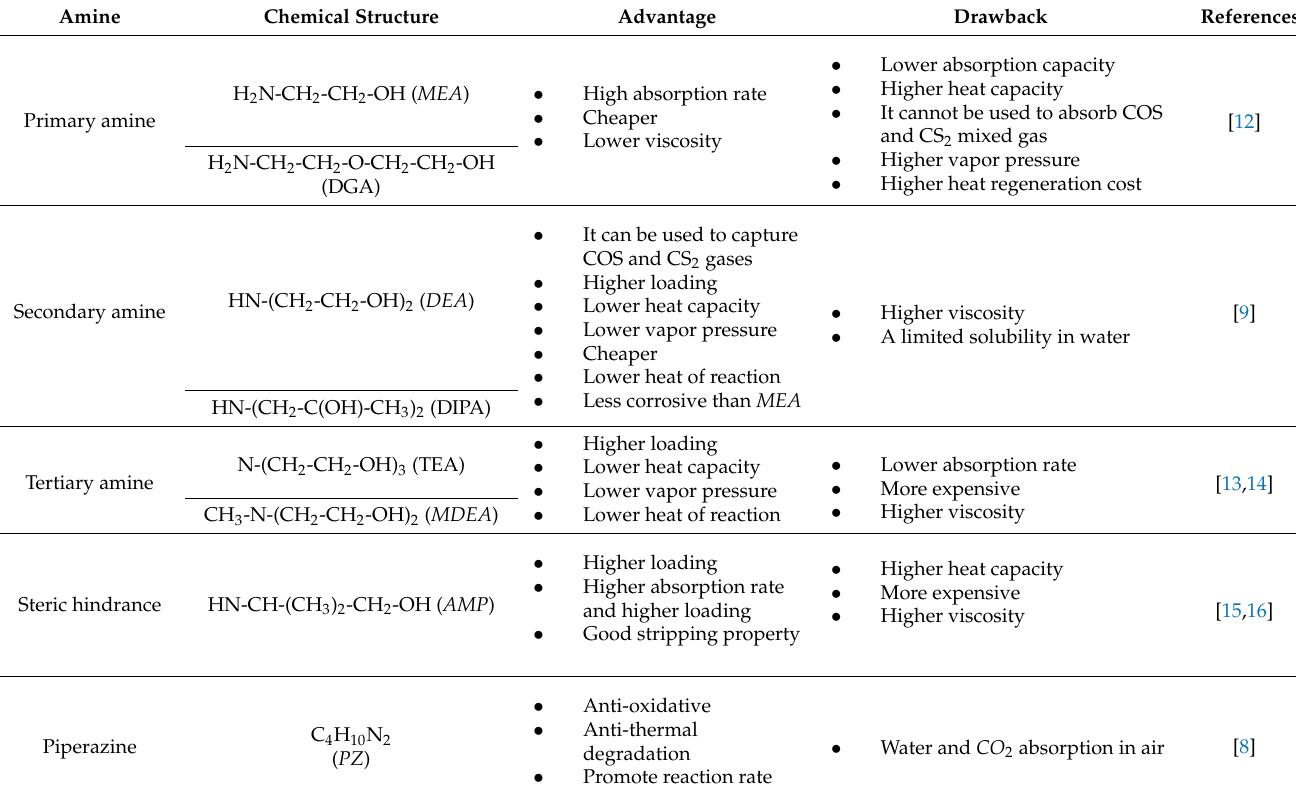
Table 1. The properties and limitations of various